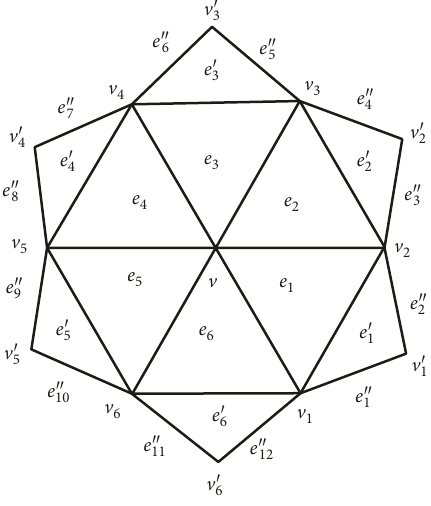
Figure 3: Sunflower graph ( Sf